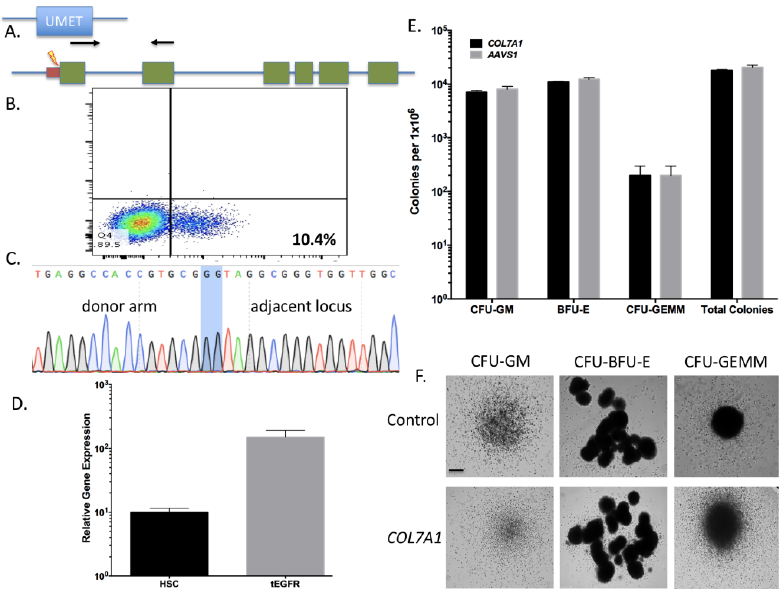
Figure 3. Hematopoietic cell engineering with transcriptional activation cassette knock in. ( A ) COL7A1 targeting donor. Arms of homology were constructed for the transcriptional start site (TSS) proximal region. The left arm contained 500 bp of sequence upstream of gRNA candidate three. The right donor arm began immediately after the TSS and extended 500 bp downstream. In between the donor arms was the UMET element: a ubiquitous chromatin opening element (UCOE) and a hybrid promoter (MND). Downstream of the promoter is the truncated non-signaling epidermal growth factor receptor (tEGFR) and a 2A peptide sequence that is in frame with the endogenous COL7A1 exon 1. Arrows are the inside/out PCR primers used for HDR detection. The donor is shown in relation to the endogenous locus. The small maroon box is the COL7A1 5’ untranslated region and the green boxes are the first six exons of COL7A1 . ( B ) Donor derived tEGFR expression. Following electroporation and AAV transduction the HSCs were assessed for locus modification by tEGFR expression using flow cytometry. ( C ) COL7A1 locus HDR. Cas9 RNP and AAV-6 donor treated cells were screened using inside/outside PCR using primes noted with black arrows in ( A ). Shaded region shows donor:endogenous locus junction. ( D – F ) Engineered HSC characterization. ( C ) HSCs were modified with Cas9 RNP and AAV-6 donor and assessed for tEGFR expression that is shown on the x -axis. ( D ) Modified HSC were sorted for tEGFR expression and analyzed for COL7A1 by qRT-PCR. Purified cells were analyzed for COL7A1 gene expression and were compared to untreated cells ( n = 3 experiments). tEGFR positive cells were analyzed for CFU potential ( n = 4 donors). ( E ) CFU colony counts. ( F ) Representative photomicrographs of the multi-lineage colonies. Black bar equals 100 microns.